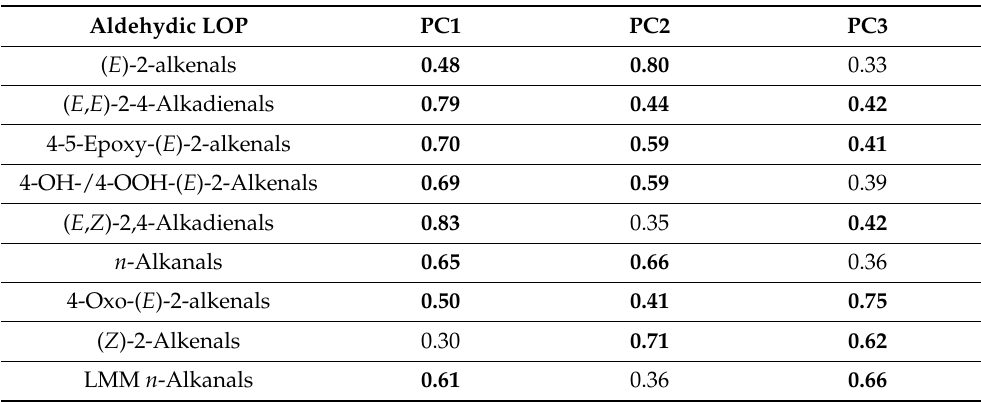
Table 4. Aldehydic LOP loadings vectors for a three-component PCA model performed on all analytical data using Varimax rotation and Kaiser normalisation. Bold values indicate significant loadings vectors, and those highlighted in yellow represent the most strongly loaded PC for each aldehyde